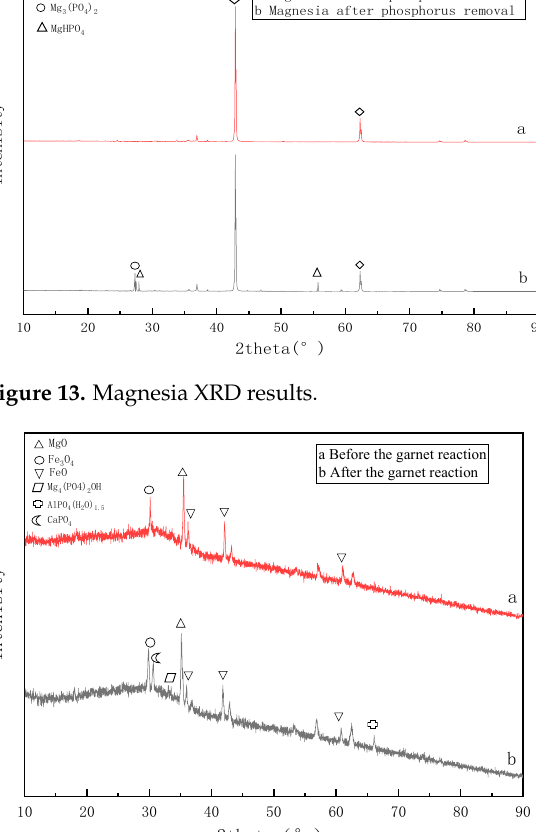
Figure 14. Garnet XRD results.